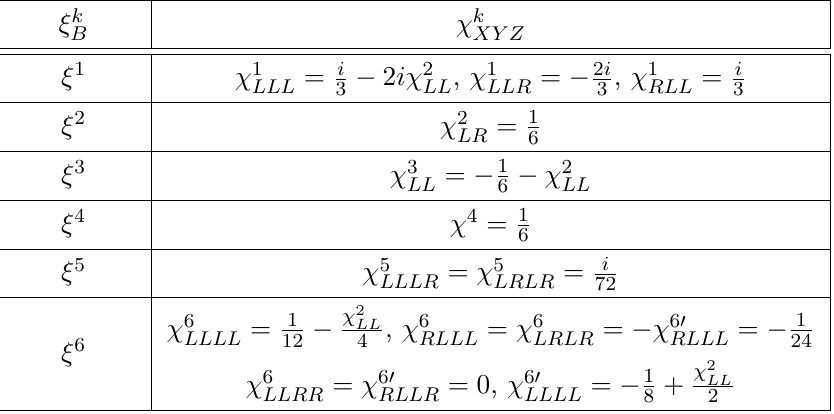
Table 6 . Explicit results at one loop in DR for the coefficients χ k entering the ξ j introduced in section 3.1, in units of 1 / (16 π 2 )